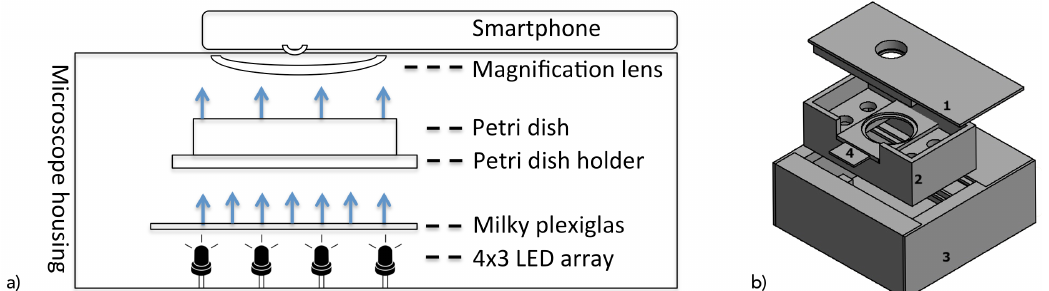
Figure 2. ( a ) Microscope casing as schematic indicating components. ( b ) Microscope casing consisting of (1) lid holding the smartphone and a 12 lens (in the cavity); (2) main carrier holding the lid within × working distance; (3) light source; (4) removable holder for Petri